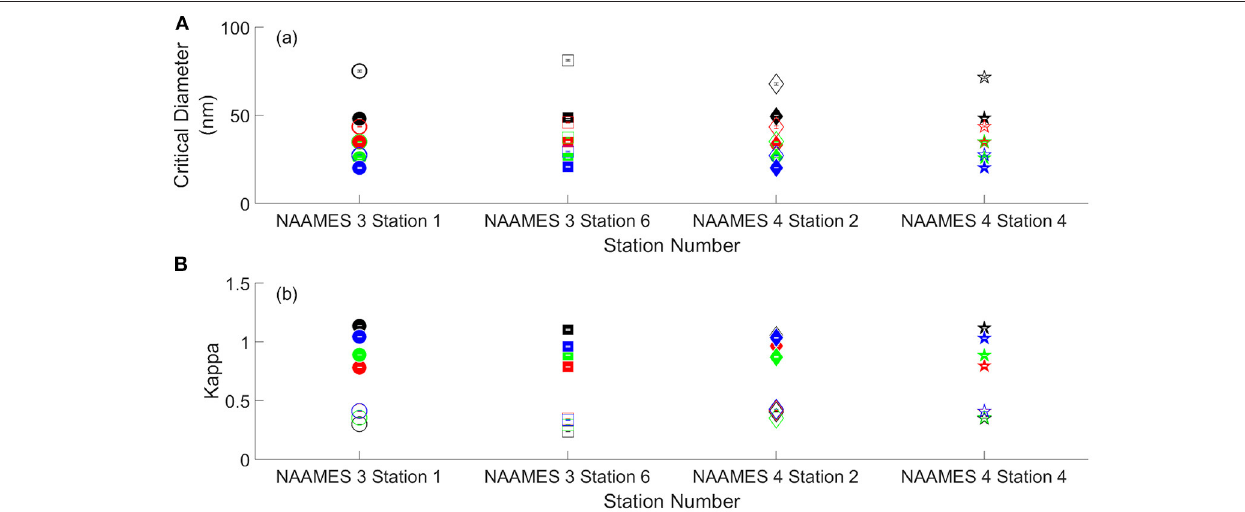
FIGURE 4 | (A) Measured critical diameters of aerosols generated from SML and DSML samples. (B) Hygroscopicity parameter, κ , values derived from CCN measurements for aerosols generated by SML and DSML samples. The black, red, green, and blue symbols indicate measurements at 0.32% 0.63% at 0.93%, and 1.24% supersaturation, respectively. The open symbols indicate DSML samples and the solid symbols indicate SML samples. Error bars show error calculated using error propagation analysis.